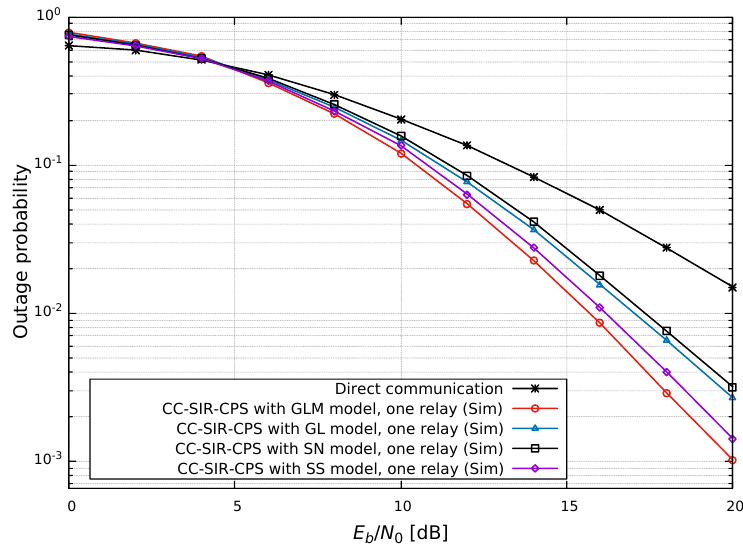
Figure 6. Simulated outage probability results versus SNR per information bit E b / N 0 at the desti- nation of the CC-SIR-CPS scheme applying the RGL, GL [9], SN [8], and SS [10] models, one relay, ρ = 0.5, and R = 0.5 bit/s/Hz.